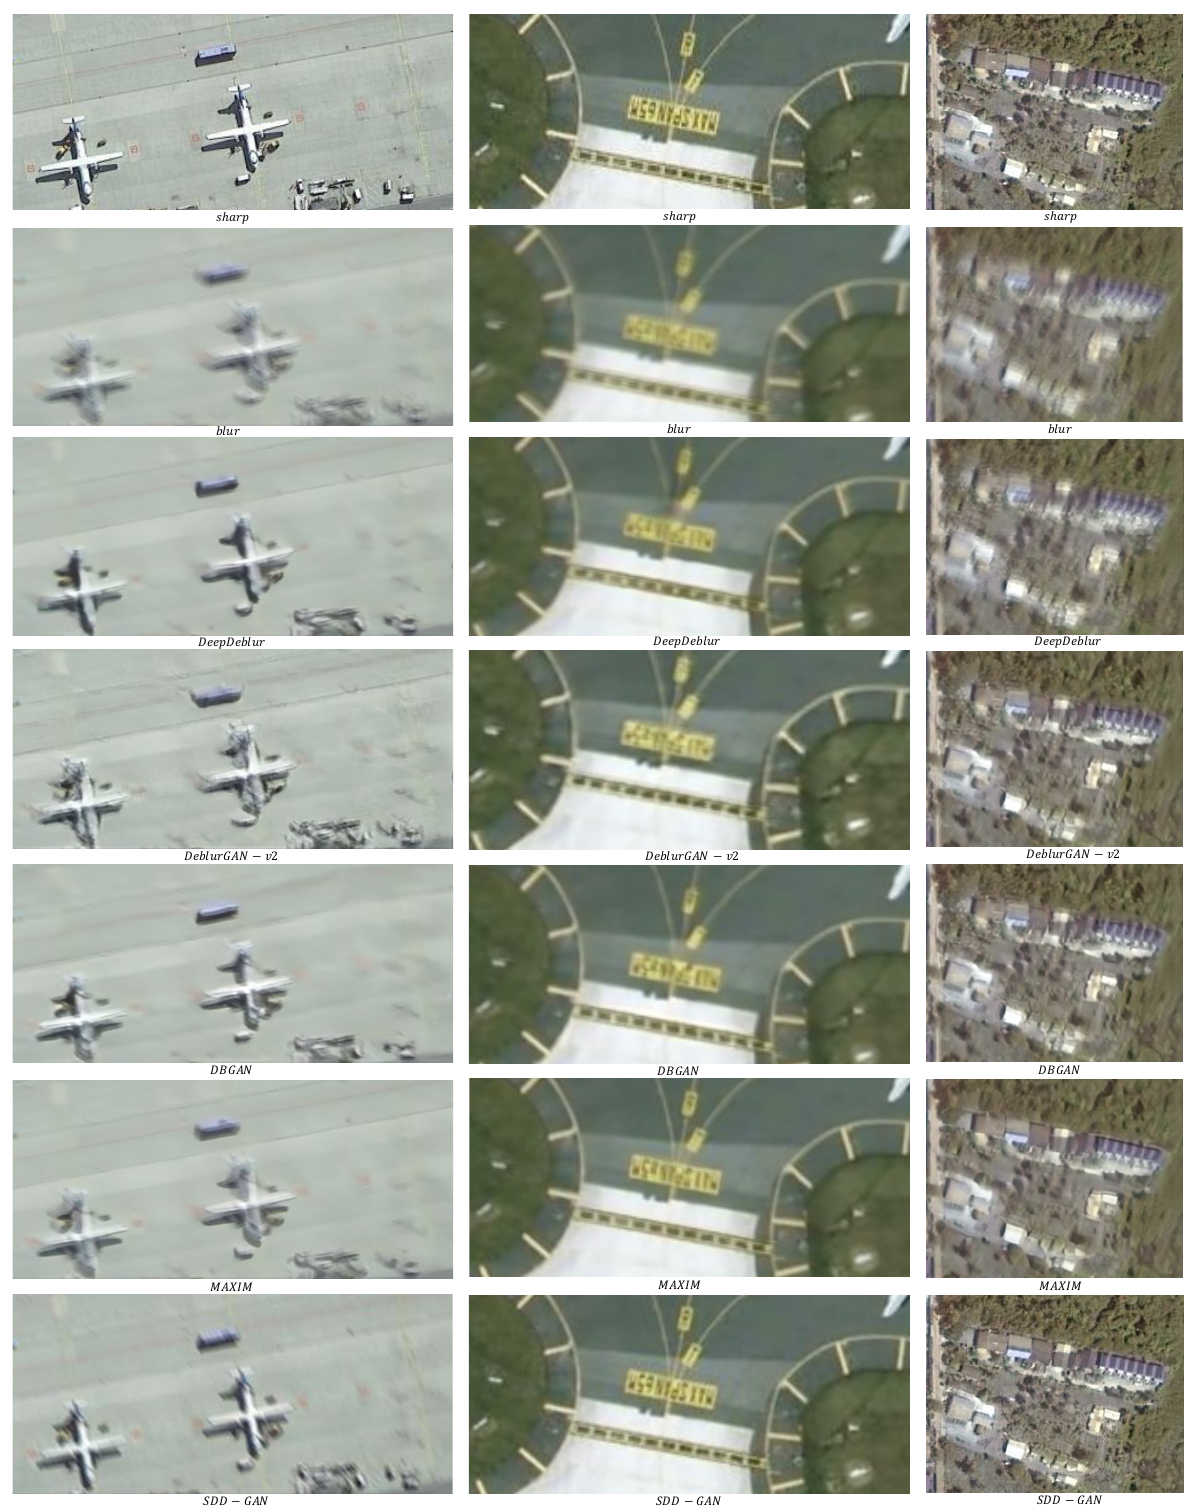
𝑆𝑆𝐷𝐷−𝐺𝐴𝑁 Figure 8. Results of different algorithms for image recovery in the RSDATA dataset. Figure 8. Results of different algorithms for image recovery in the RSDATA